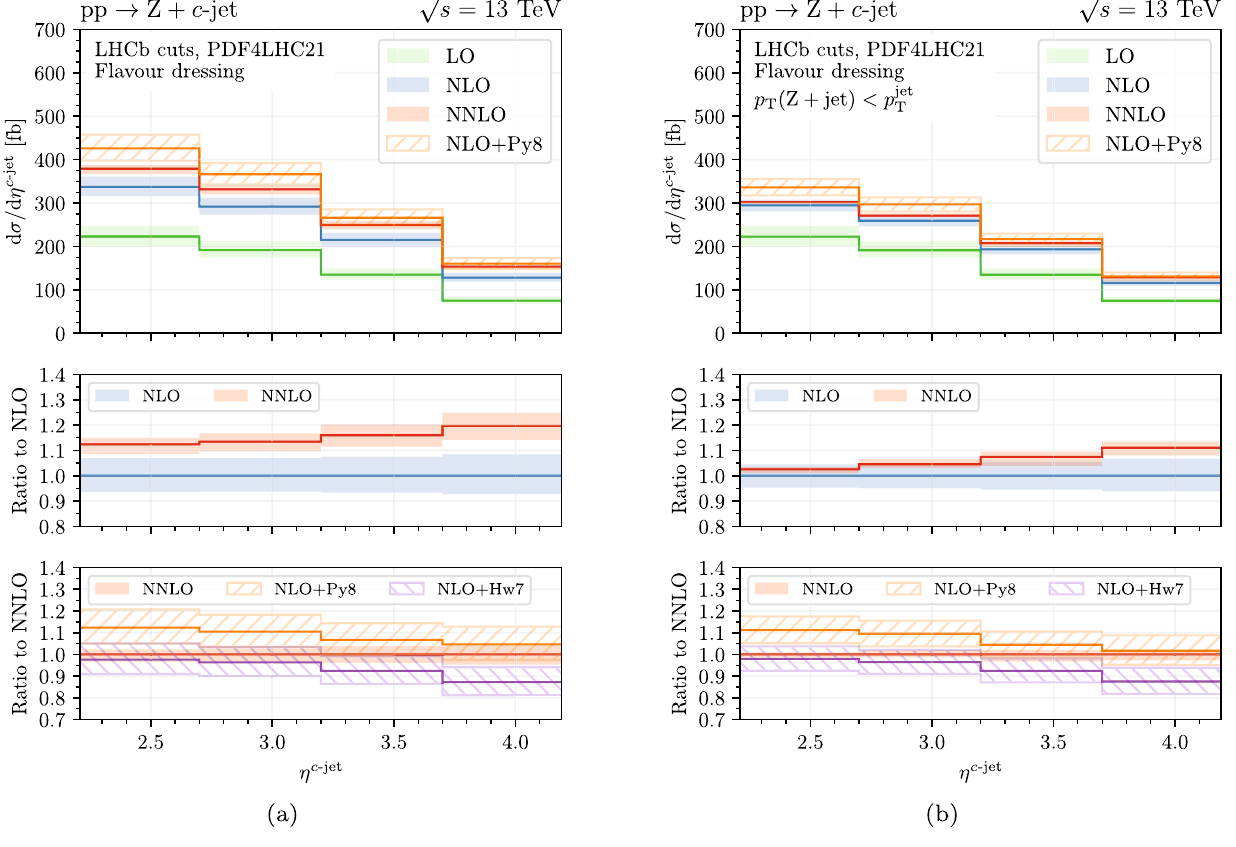
dictionswith Pythia8 (orange)or Herwig7 (purple)aspartonshowers. A dynamical cut on the transverse momentum of the Z + jet system is further applied in